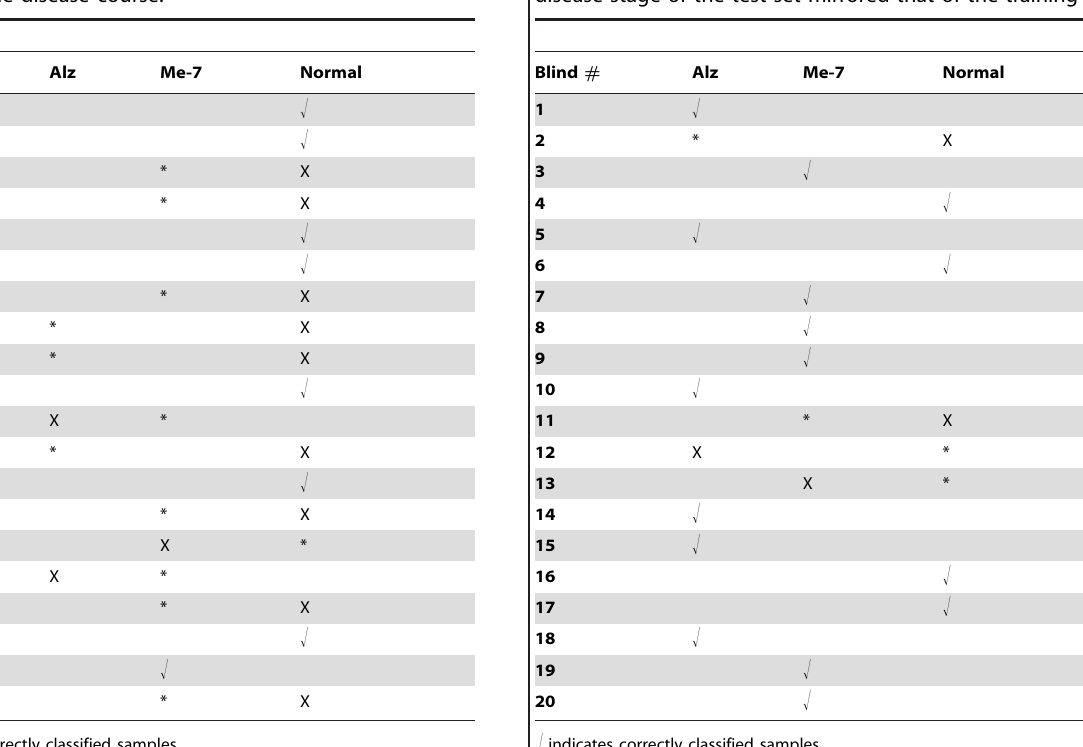
Table 3. Classification results applying the 20 protein Disease Discriminant Classifier to 20 naı¨ve samples acquired from earlier in the disease course.